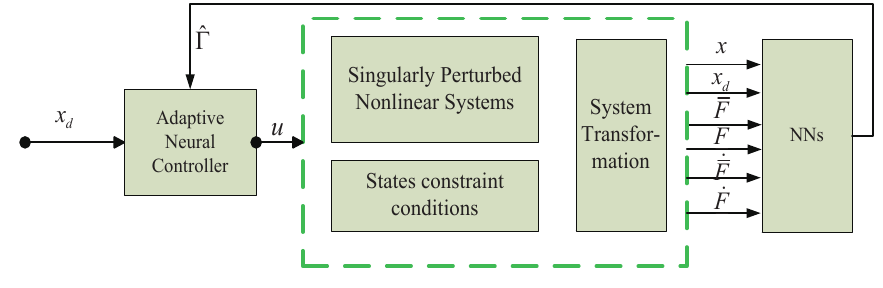
Figure 1. The general block diagram of the problem